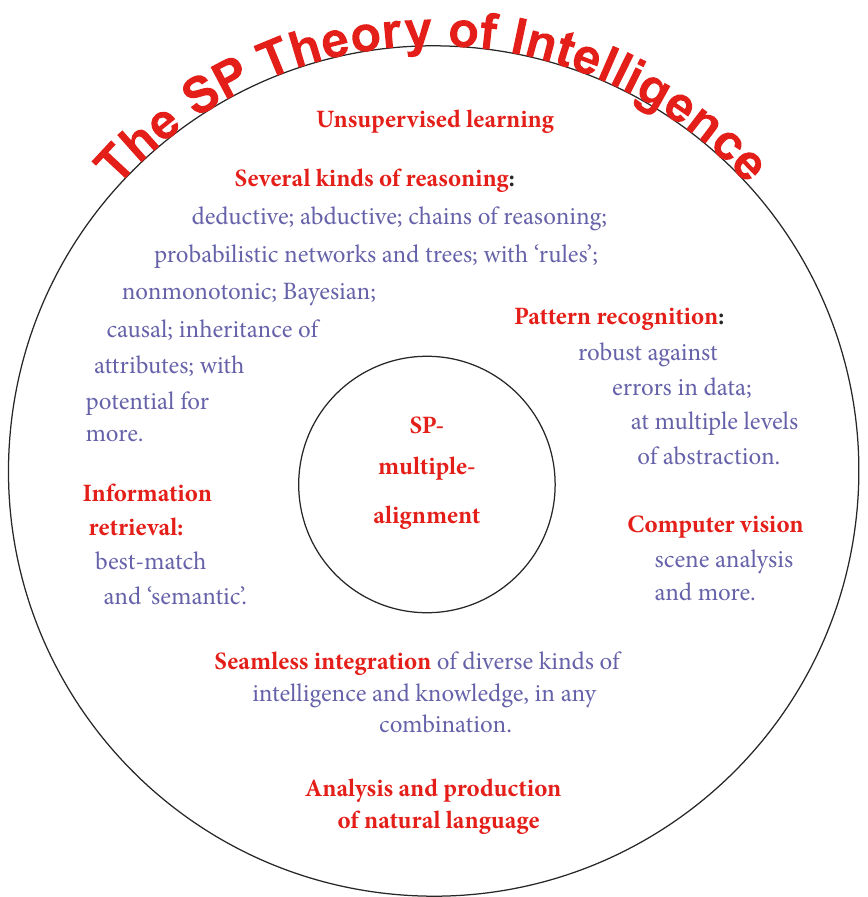
Figure 6: A schematic representation of versatility and integration in the SP System, with SP-multiple-alignment centre